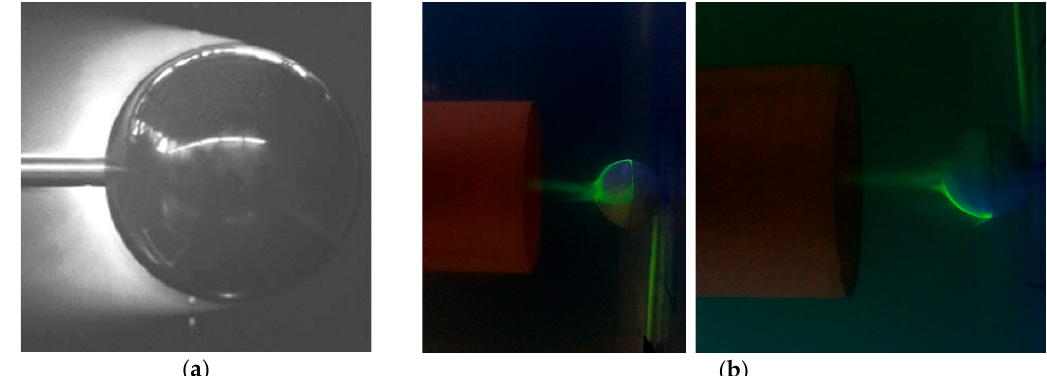
Figure 18. Flow visualization results for flow around a sphere in the uniform flow ( Re = 50,000) [34] ( a ) and the suction flow ( Re = 50,000) ( b ).